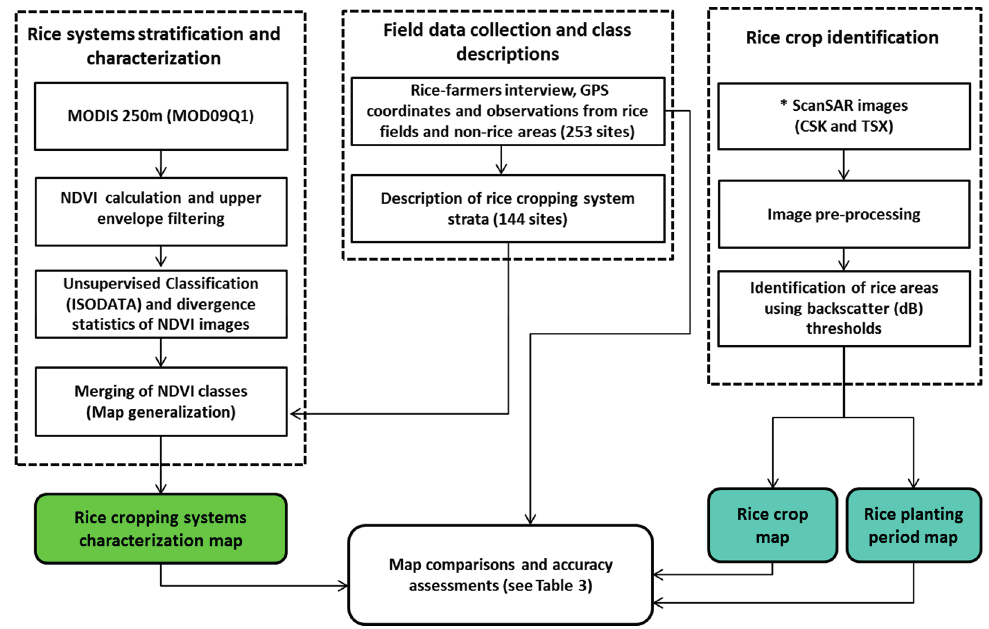
Figure 2. Flow chart of data processing method. The asterisk (*) indicates the use of MODIS in determining the dates for acquisition of ScanSAR